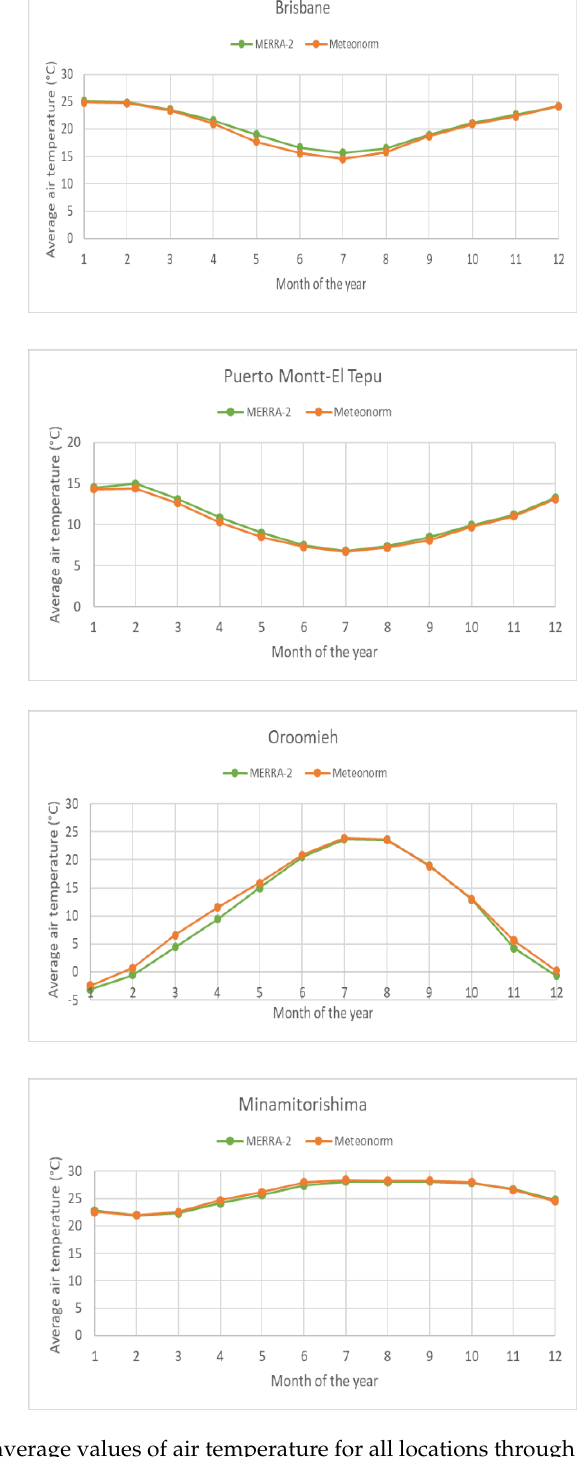
Figure 2. MERRA-2 and Meteonorm comparison for monthly average values of air temperature for all locations through years 2000–2009.